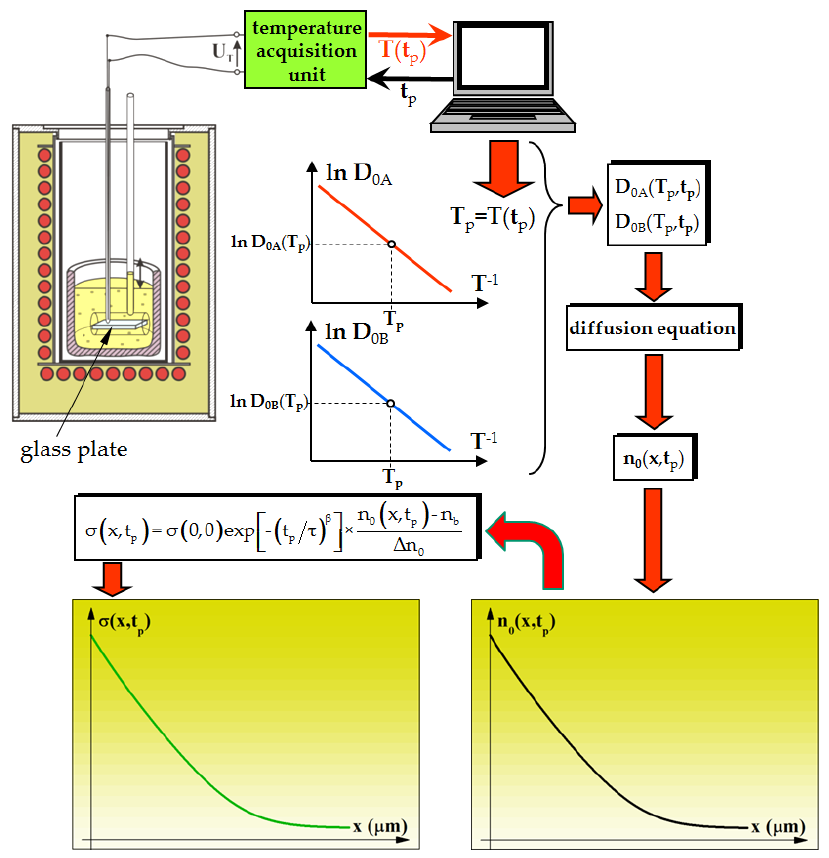
Figure 3. The principle of monitoring stresses generated in glass in real time based on temperature